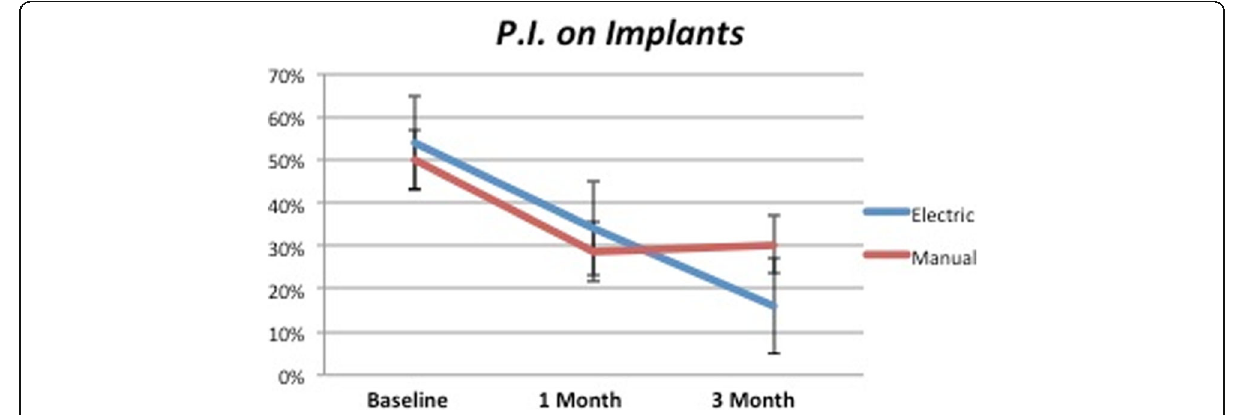
Fig. 3 PI on dental implants. Test values keep reducing after 1 month while control maintains the same